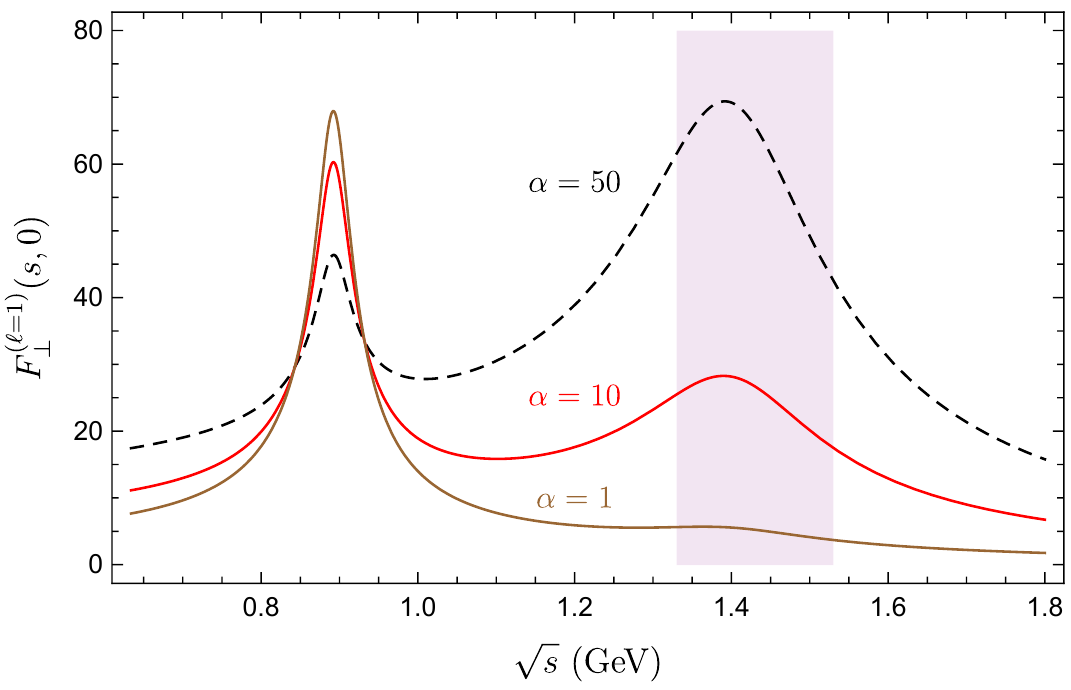
Figure 3 . Form factor F ( ‘ =1) ( s; 0) at q 2 = 0, as a function of the K(cid:25) invariant mass, for three ? di(cid:11)erent values of the parameter (cid:11) , describing the relative size of K (cid:3) (892) and K (cid:3) (1410) contribu- tions. All the curves are consistent with the Light-Cone Sum Rule. The vertical band indicates the region of the measurements in ref.